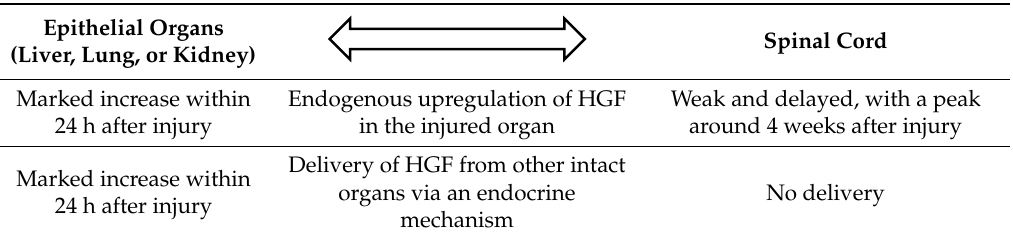
Table 1. Differences in the hepatocyte growth factor (HGF) supply system after tissue injury between epithelial organs and the spinal cord. Compared to epithelial organs, including the liver, lung, and kidney, the injured spinal cord has a poor ability to upregulate endogenous HGF, nor does it receive HGF supplied from other organs.